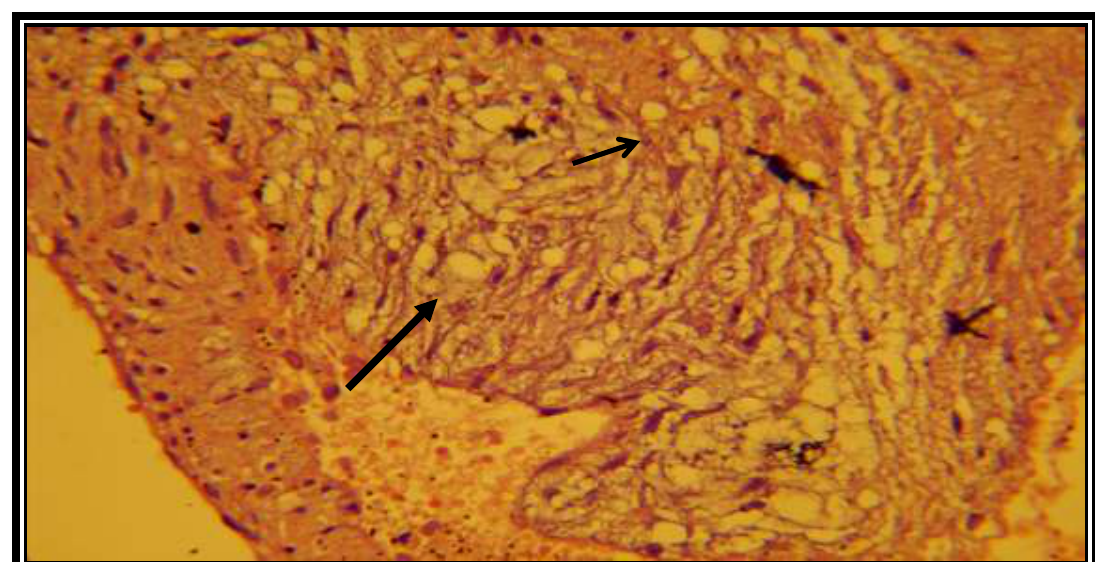
Figure ( 4 ) Histological section of pulmonary artery of H 2 O 2 treated rats dense thickness of intima in muscular layer of blood vessel lead to narrowing of its